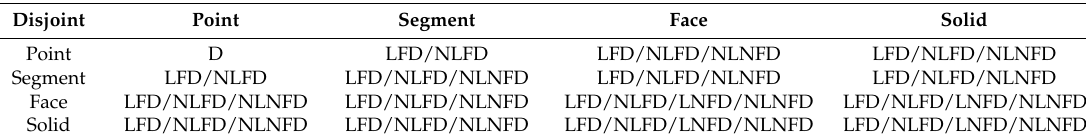
Table 4. Disjoint topological relation among objects in a 3-D cadaster.